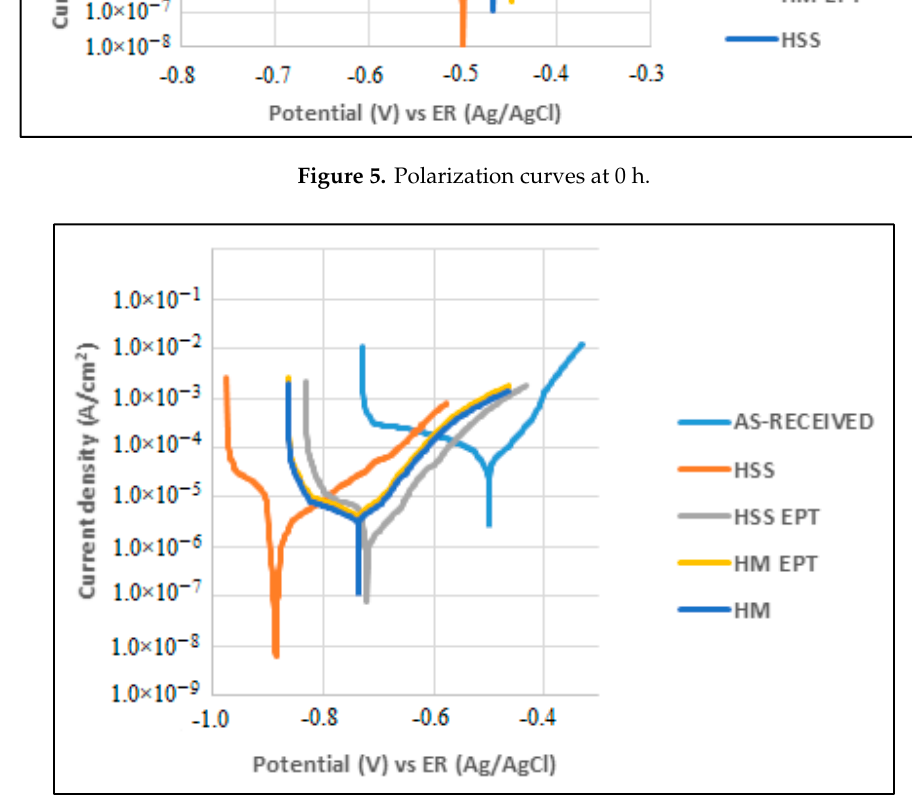
Figure 6. Polarization curves at 24 h. Table 5. Extracted data from the polarization curves on cross